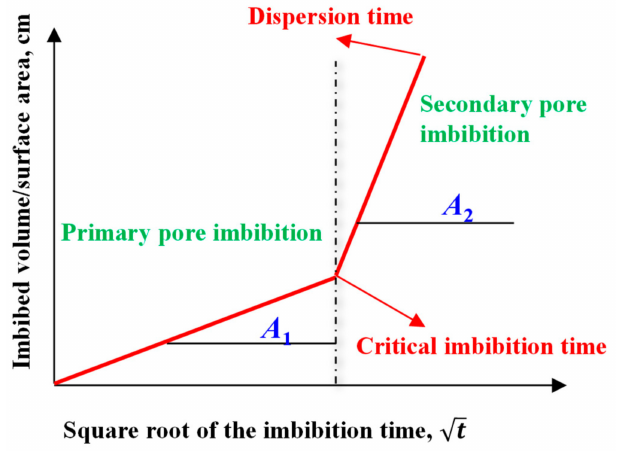
Figure 9. Schematic diagram of imbibition curve in hydrate